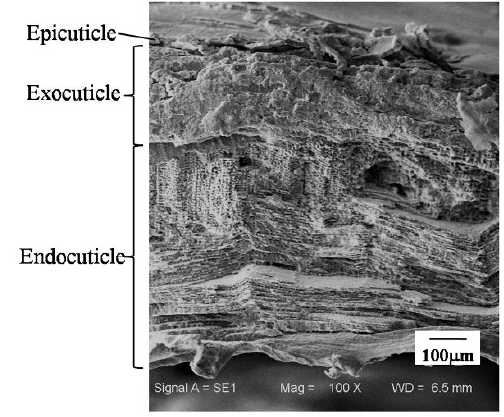
Figure 3. Multilayered structure of Chinese mitten crab dactylopodite.